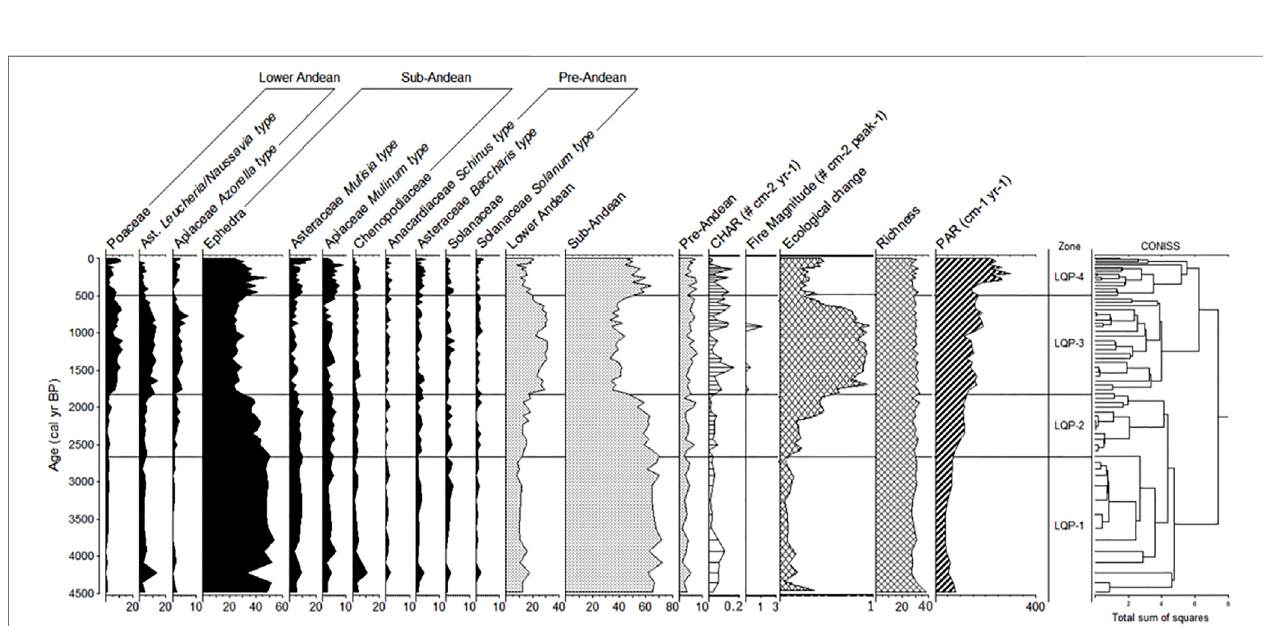
FIGURE4| PollendiagramofthepercentageofthemaintaxaofLagunaCorralito.Thecarbonaccumulationrate “ CHAR ” (#particlescm-2 years-1),themagnitude ofthe fi re(#particlescm-2peak-1),andthepollenaccumulationrate “ PAR ” (#pollengrainscm-2 years-1)areshown.Thevaluesoftheecologicalchangeandthepollen richness recorded throughout the record are also shown.